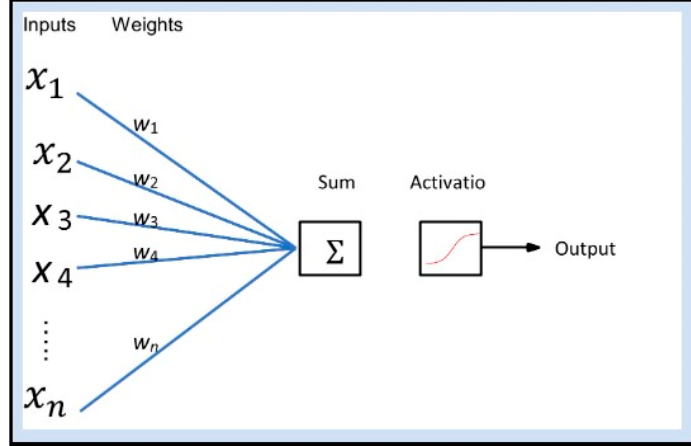
Figure 13. Structure of a multi-neural network.